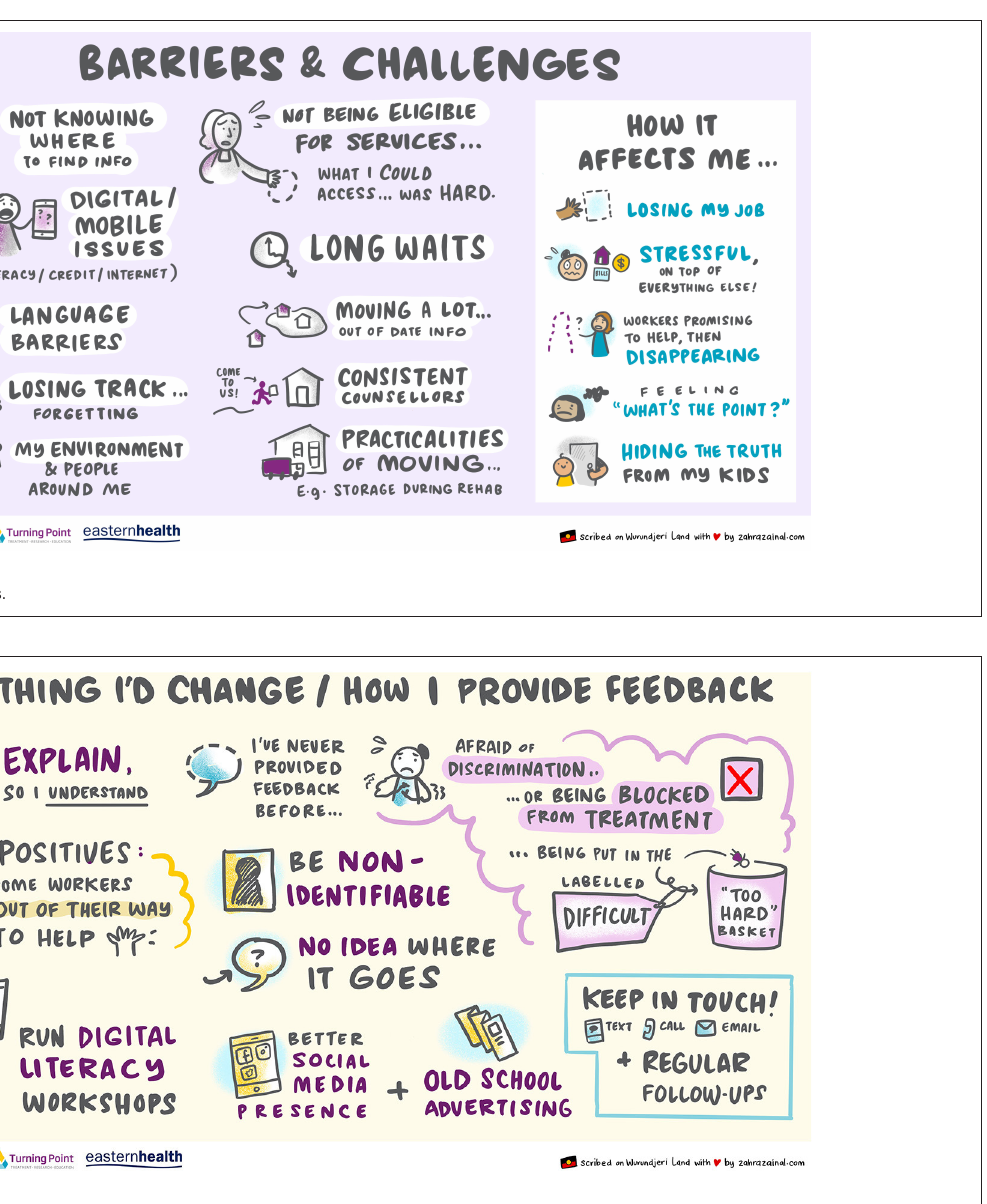
FIGURE 2 | One thing I would change/how I provide